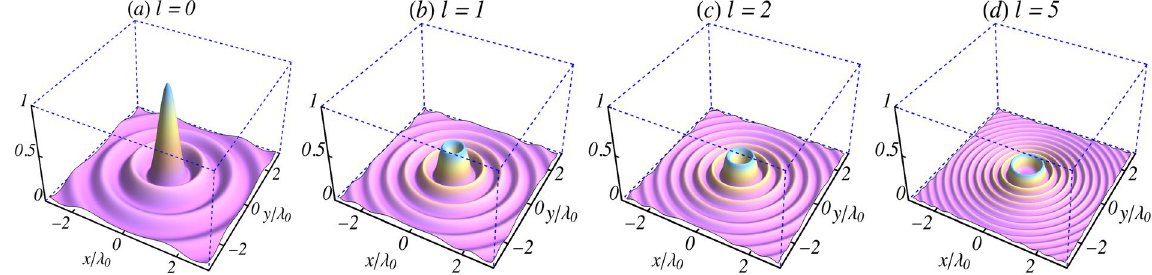
Figure 1. Surface plots of the initial ( t = 0) vector potential intensity profile | A (0) / a 0 | 2 in the focal plane ( z = 0) of ultrashort ( L = 1.5 λ 0 ) and tightly focused ( w 0 = 0.8 λ 0 ) laser pulses of central wavelength λ 0 = 1 μ m, propagating in vacuum ( n 0 = 0). Other parameters used are: ϕ 0 = 0 and k r = x 1, l / w 0 , where x 1, l is the first zero of J l ( x